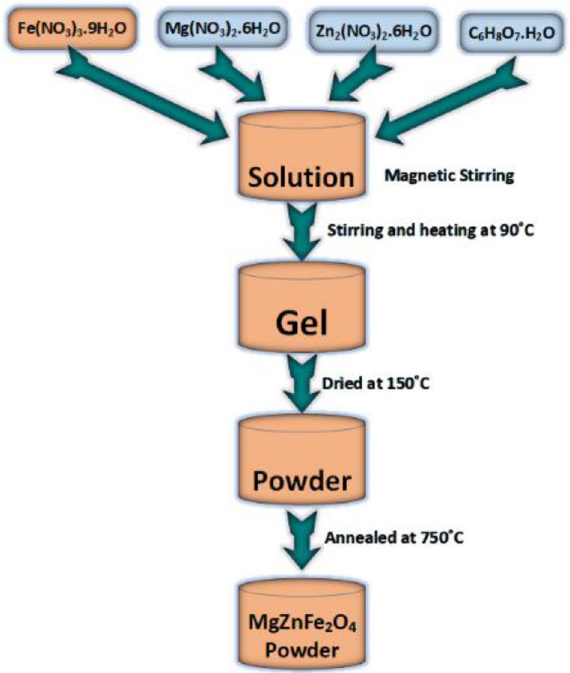
Figure 1. Flowchart of MgZnFe 2 O 4 nanoparticle preparation.